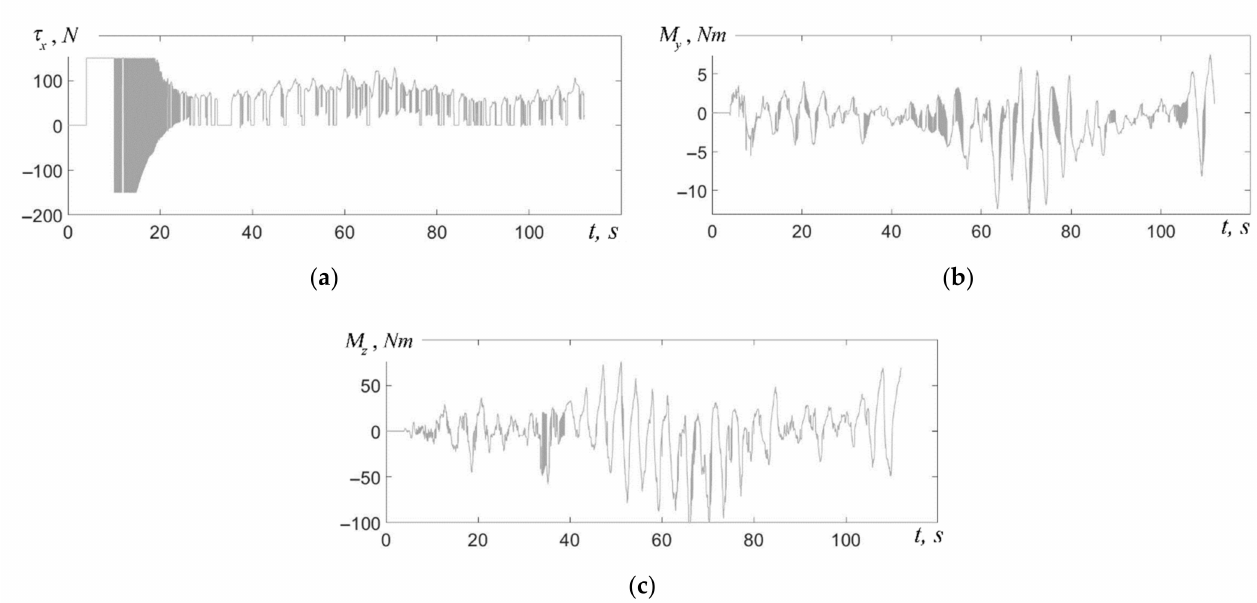
Figure 9. The changes of control signals of AUV-follower, taking into account the errors in determining the position and orientation of the AUV-leader: ( a ) is the τ x ; ( b ) is the M y ; ( c ) is the M z